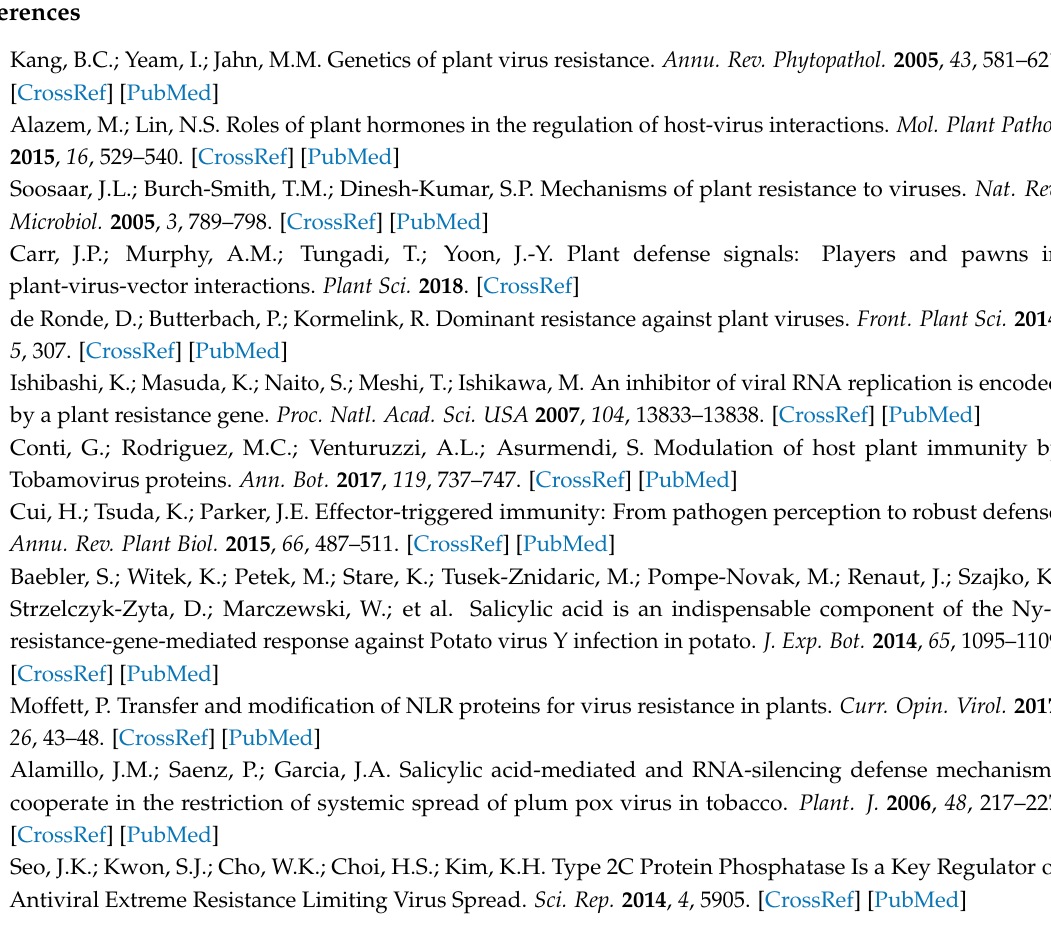
s1. Figure S1: Heatmap of genes involved in the SA pathway. Figure S2: Heatmap of genes involved in the cytokinin pathway. Figure S3: Heatmap of genes involved in the brassinosteroid pathway. Table S1: Validation of RNAseq data by RTqPCR. Table S2: Top G5H-upregulated genes in plants infected with SMV-G5H and SMV-G7H at 8, 24, and 54 hpi. Table S3: Enriched pathways of upregulated and downregulated DEGs in G5H-infected